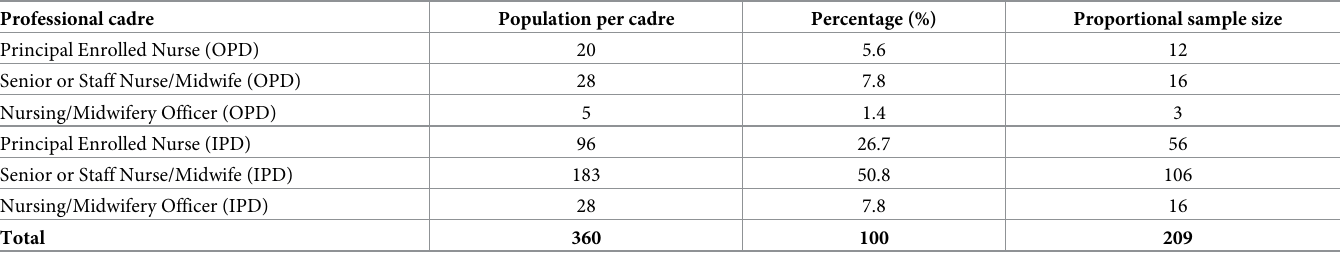
Table 1. Selection based on probability proportional to strata size